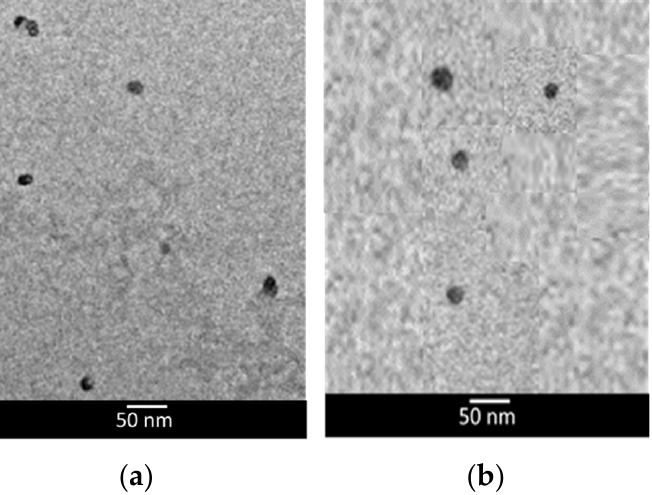
Figure 3. Transmission electron microscopy (TEM) images of unloaded lipid nanoparticles ( a ) and LP2-loaded lipid nanoparticles ( b ).